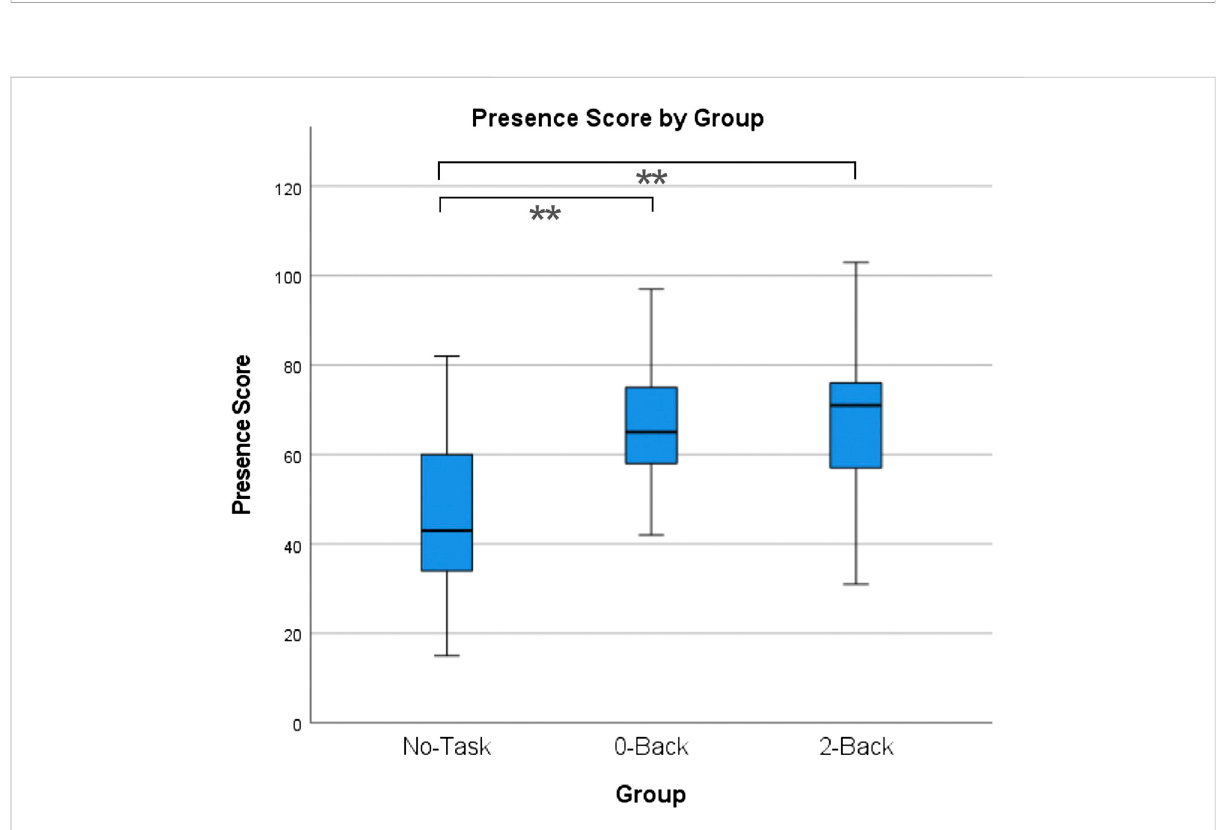
FIGURE 6 Boxplots of Presence scores by Group; ** = signi fi cant difference at a p < 0.01 level.